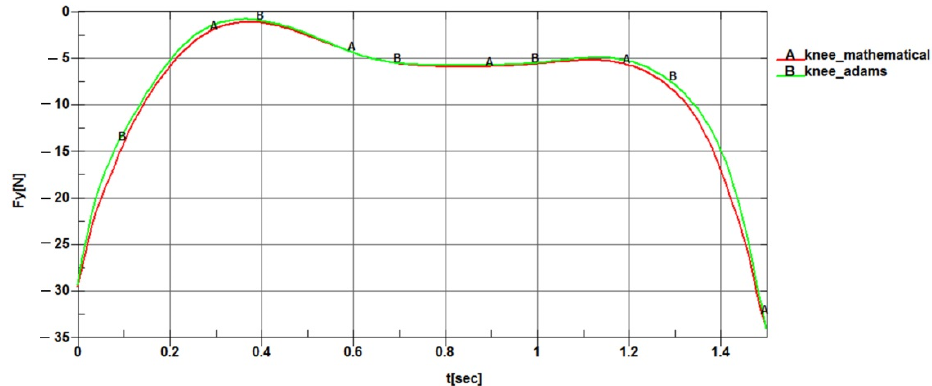
Figure 16. Connection forces component on y-axis for knee joint vs. time (with ground contact).